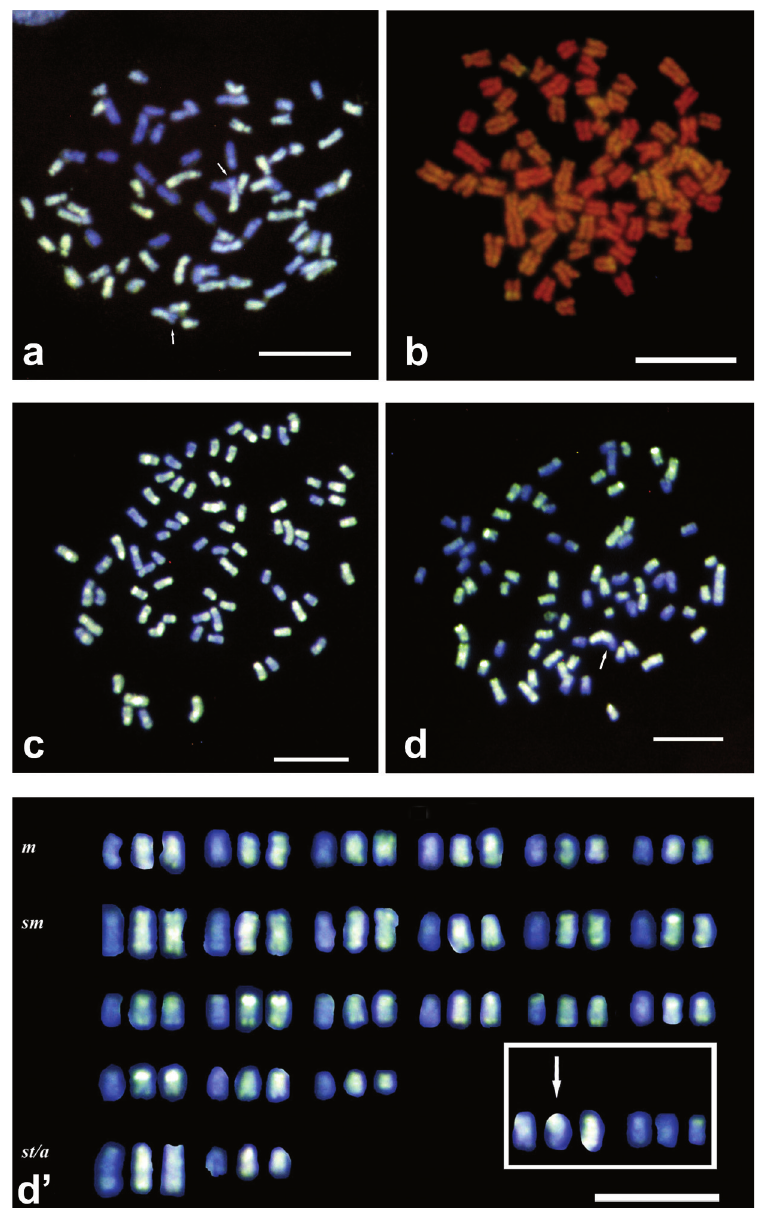
Figure 2. Improved use of GISH method and putative karyotype in specimens of S. alburnoides complex a GISH with AA Dig labeled probe in PAA metaphase plate revealed by anti-Dig FITC antibody counter- stained with DAPI. Picture without photo editing. First improvement step b-d GISH with AA Dig labeled probe in PAA metaphase plates revealed by anti-Dig FITC antibody counterstained with DAPI ( c and d) and PI ( b) . Pictures with little photo editing. Last improvement step d' Putative PAA karyotype. Arrows indicate chromosomes putatively involved in exchanges, and box in karyotype some unresolved chromo- somes. Scale Bars =